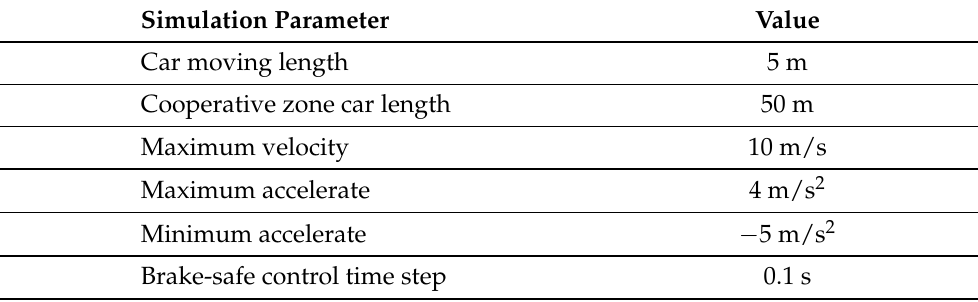
Table 4. System simulation